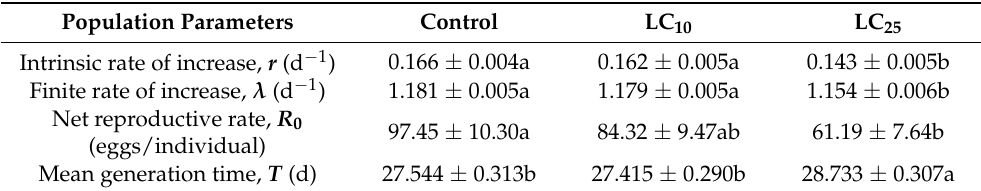
Table 4. The effects of sublethal concentrations of Beauveria bassiana BEdy1 on population parameters of F 1 generation of Sogatella furcifera